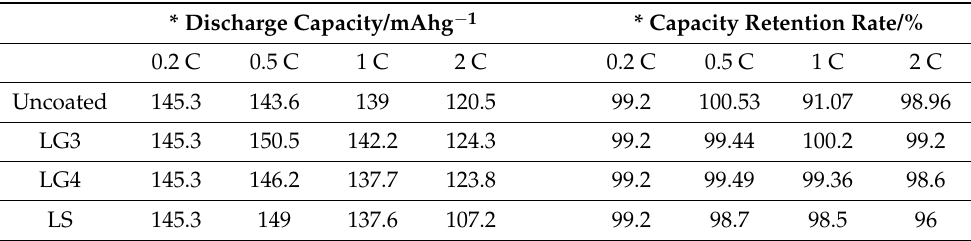
Table 6. The data of discharge capacity and capacity retention rate of assembled lithium batteries at different discharge rates.